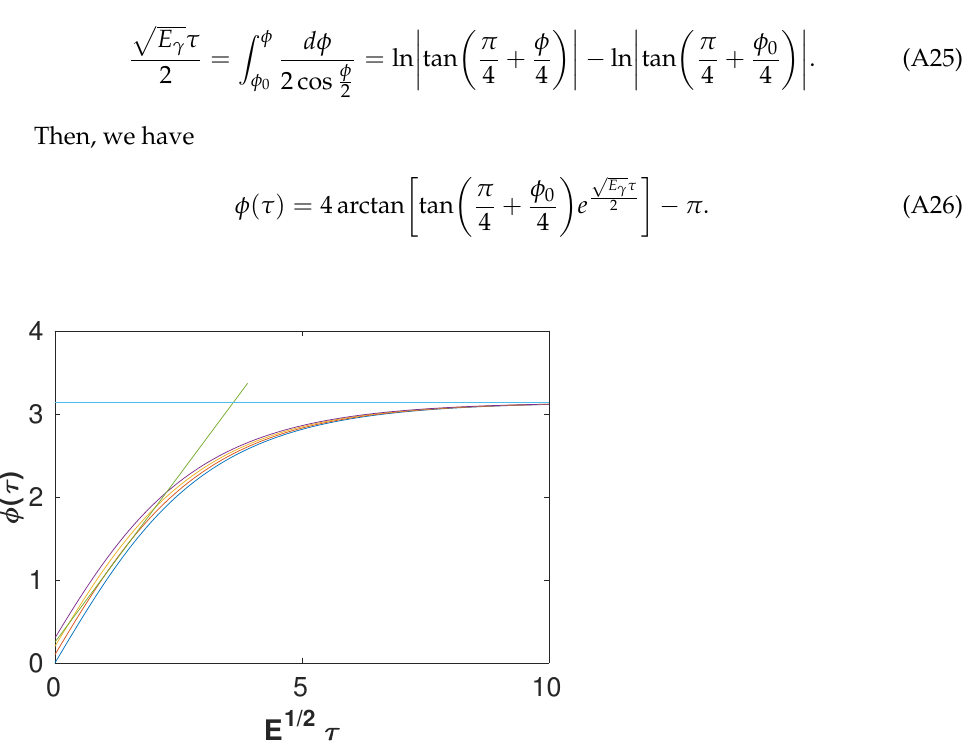
Figure A1. The solution φ ( τ ) in Equation (A26) for fitting plots correspond to the initial and the large time asymptotes, which are φ ( τ ) = 0.25 + 0.8 and φ ( τ ) = π